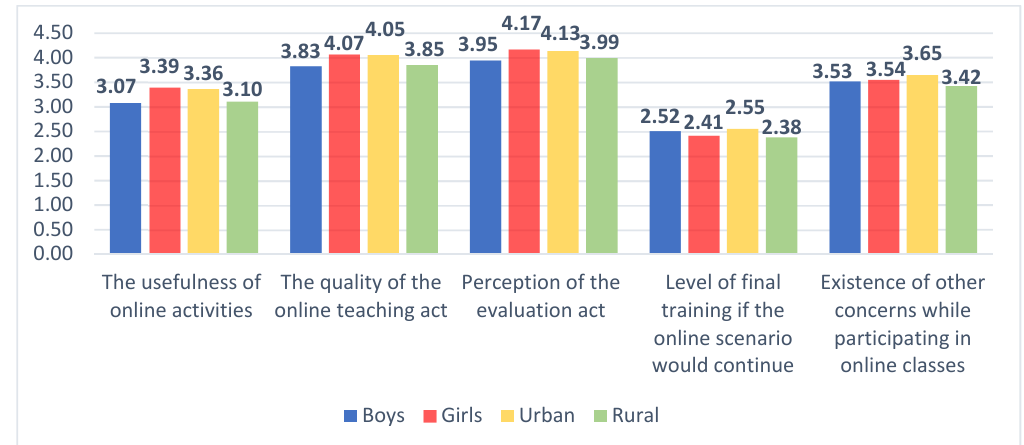
Figure 4. The average values of the answers for the items of the efficiency factor.